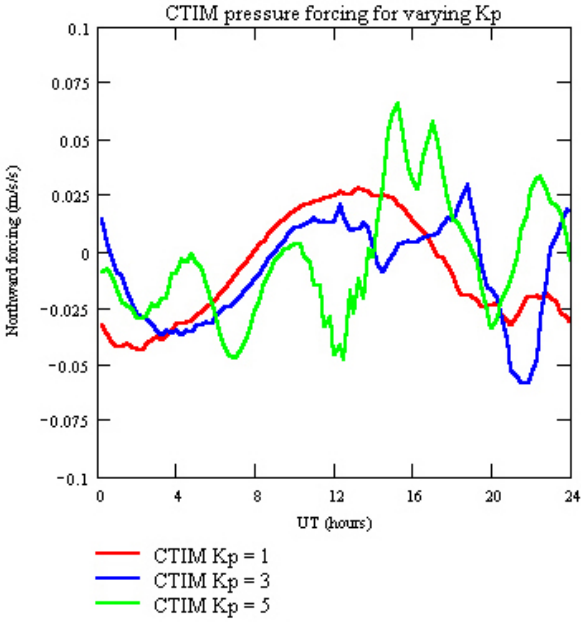
Fig. 8. The ion drag acceleration through the day for the same K p levels as in Fig. 7.